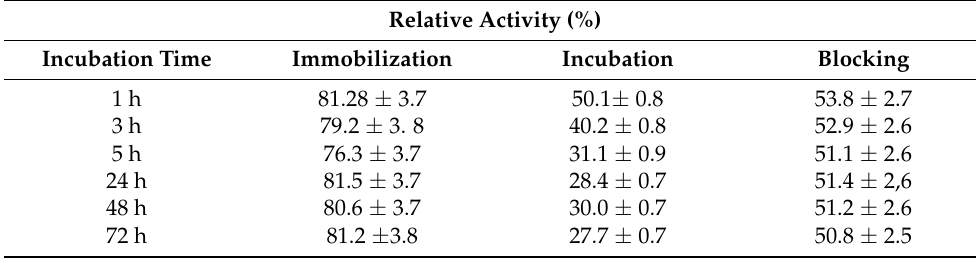
Table 4. Effect of the incubation time in the relative (considering 100% of the activity of the enzyme offered for the immobilization) hydrolytic activity of PGA biocatalysts immobilized in 5 mM of sodium phosphate at pH 7.0 and incubated in 25 mM of sodium carbonate (100 mM of phenylacetic acid and 30% glycerol) at pH 10.0. Blocking was performed with glycine. The experiments were conducted as described in the Methods Section.